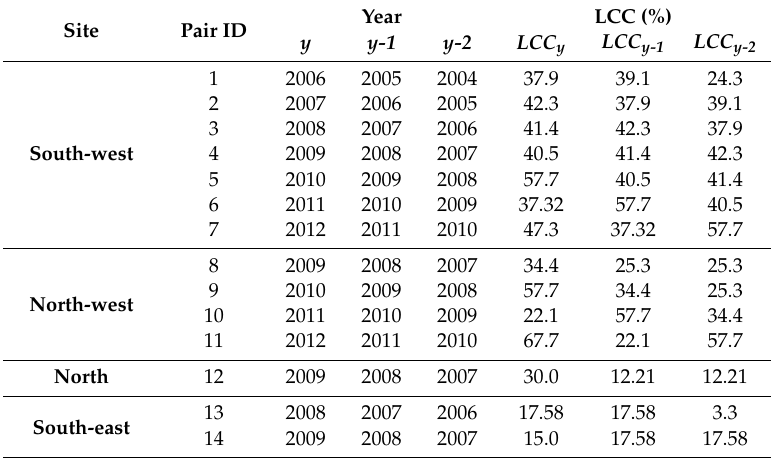
Table 1. Pairs of LCC data used as constraints to the linear